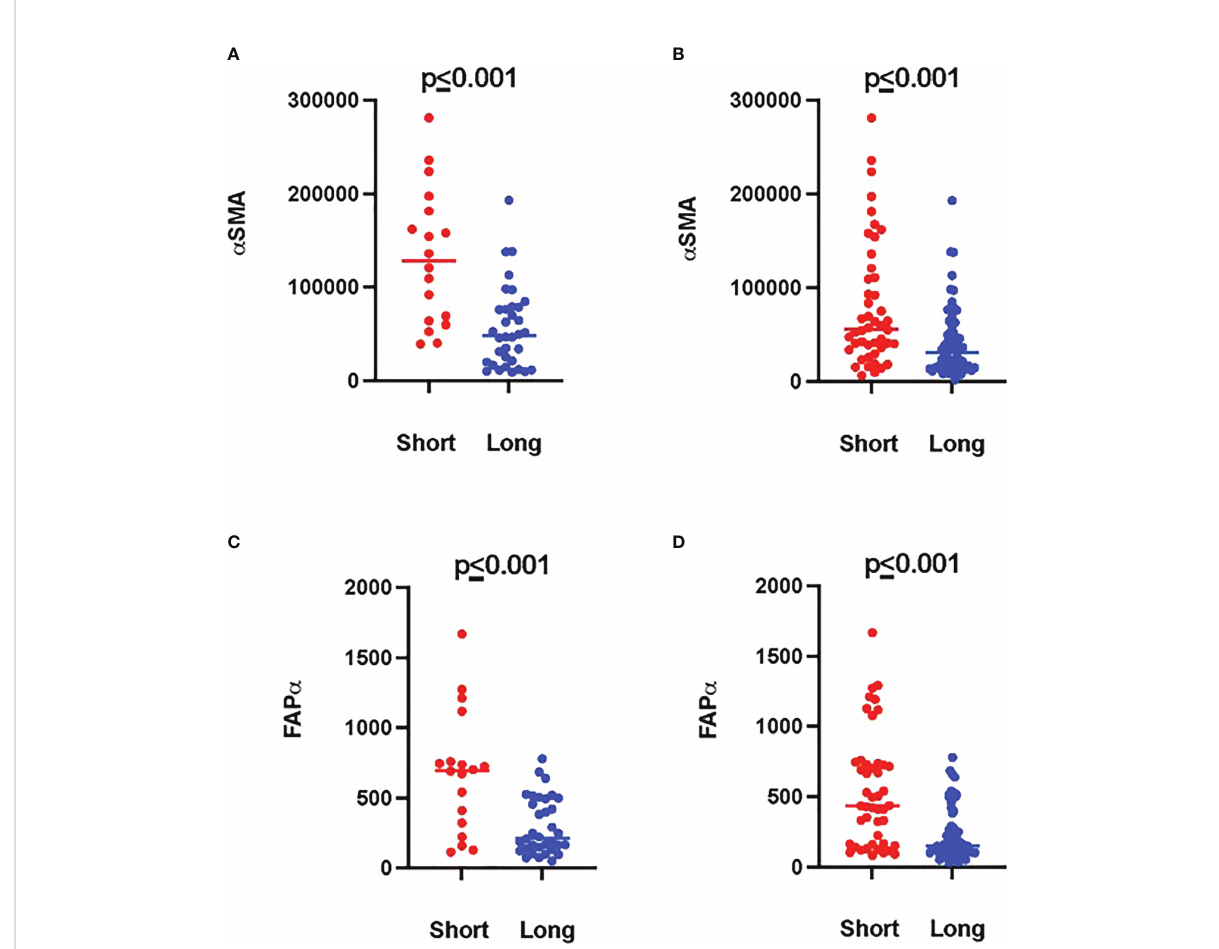
FIGURE 3 Higher amounts of desmoplastic proteins were found in short-term survivors. (A) The expression of a SMA in the desmoplastic areas, (B) in the desmoplastic and tumor-rich areas combined. Y-axis is the normalized counts of a SMA antibody. (C) The expression of FAPa proteins in the desmoplastic areas, (D) in the desmoplastic and tumor-rich areas combined. Y-axis is the normalized counts of FAPa antibody. Each dot presents an ROI and the line presents the average normalized counts of the antibody in each group. Blue color presents long- and red color presents short-term survival samples. The two proteins were found to be signi fi cantly higher in short- compared to long-term survivors using the GeoMx ™ DSP technology (non-parametric Mann-Whitney U